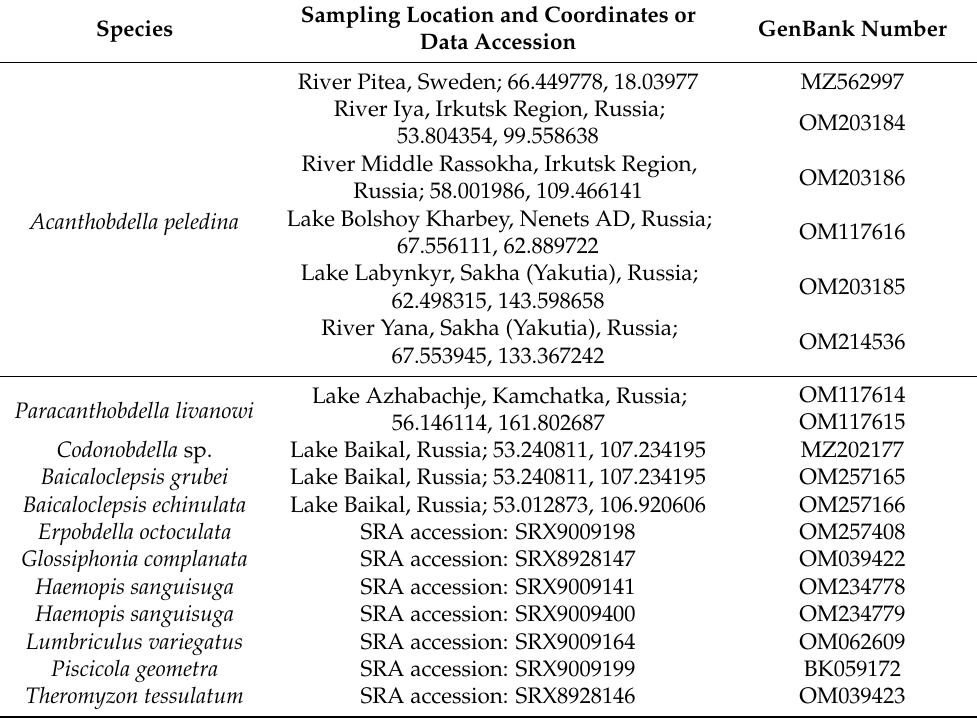
Table 1. List of the Clitellata mitochondrial genomes obtained in this study, with their sampling locations (for newly sequenced samples), Sequence Read Archive accession numbers (for re-assembled samples from public data) and GenBank accession numbers. Sampling Location and Coordinates or GenBank Species Data Accession